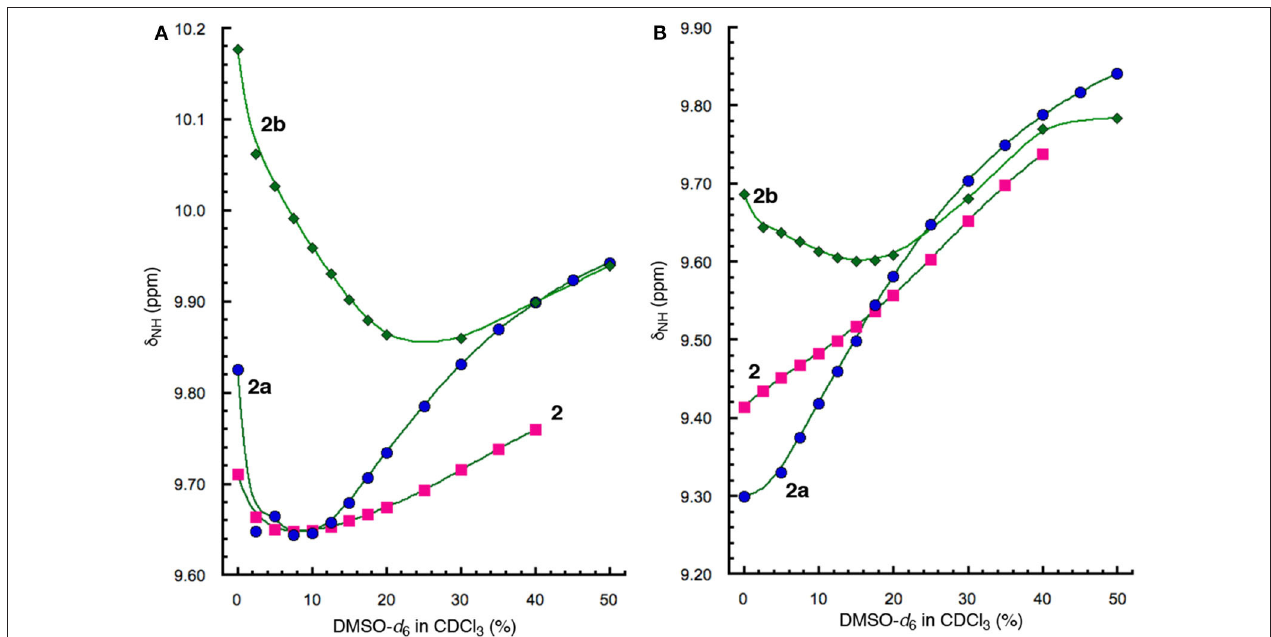
Table 2 lists the difference in the chemical shifts of